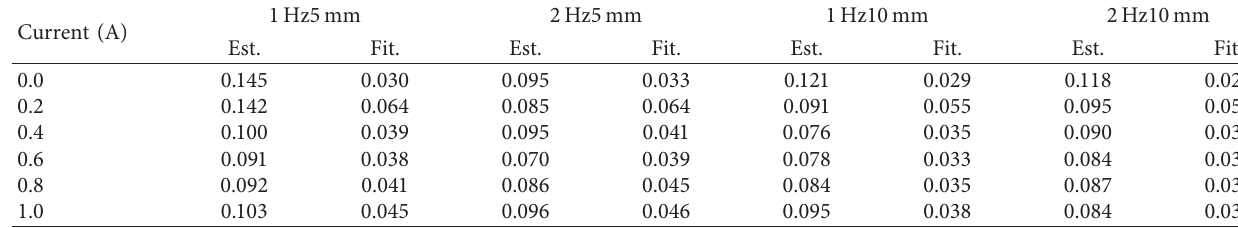
Table 1: RMSE for estimated and fitting results under different sinusoidal excitations.